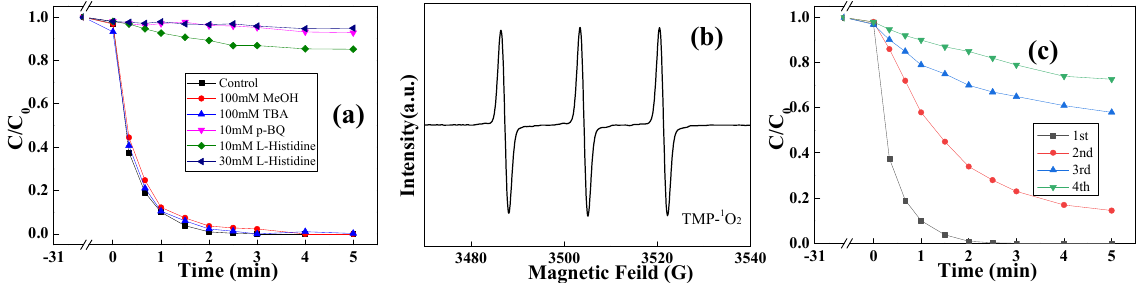
Figure 7. ( a ) BPA degradation in N-PPB600/PMS system at the existence of various scavengers, ( b ) ESR spectra test, ( c ) recyclability test for N-PPB600 ([catalyst] 0 = 0.5 g/L, [BPA] 0 = 0.02 mM, [PMS] 0 = 1.5 mM).